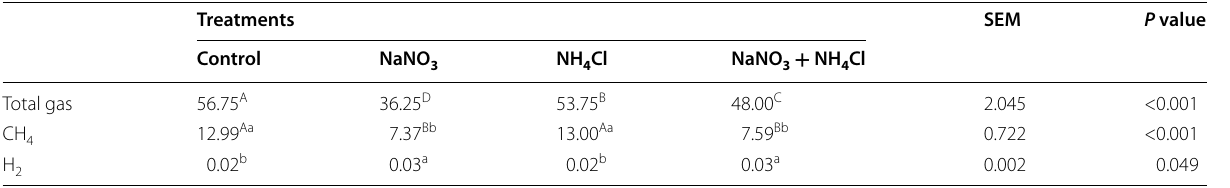
Values with different lowercase or capital superscripts in the same row differ significantly at P < 0.05 and P < 0.01, respectively